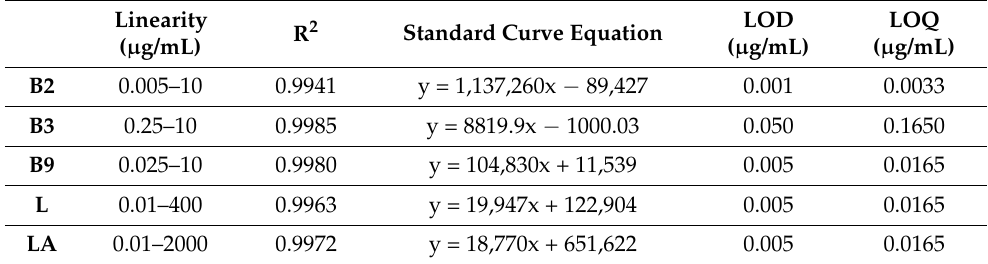
Table 2. Validation of the analytical method. LOD—limit of detection; LOQ—limit of